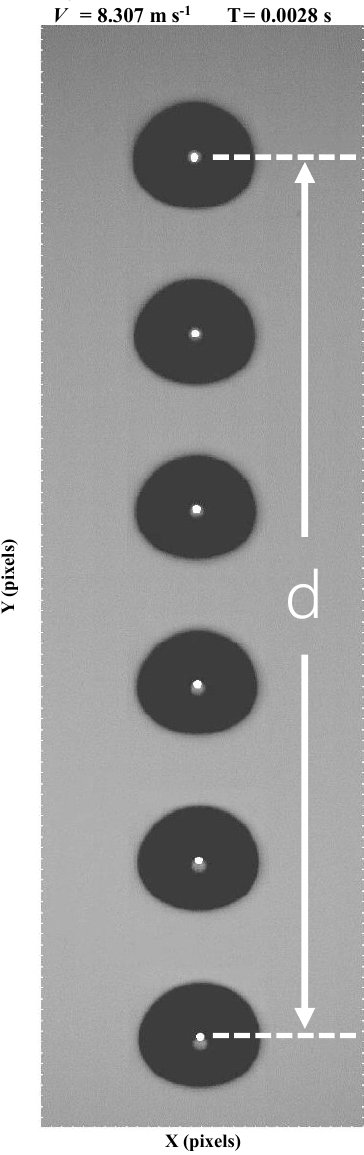
Figure 5. Multiple sequences of the photographed images as a sam- ple water drop fell into the view frame of HSC. White dots indicate corresponding geometric center of the drop at different time. The vertical distance between the highest and lowest geometric center within the view frame is indicated by “ d